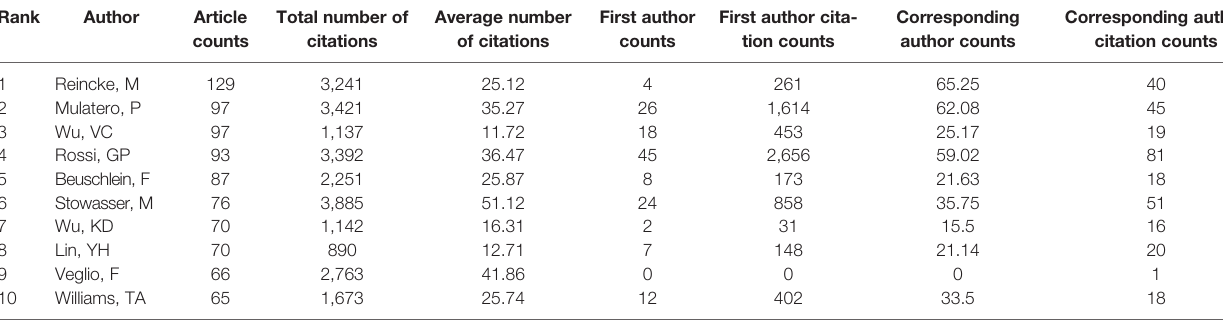
TABLE 5 | The top 10 most productive authors in PA